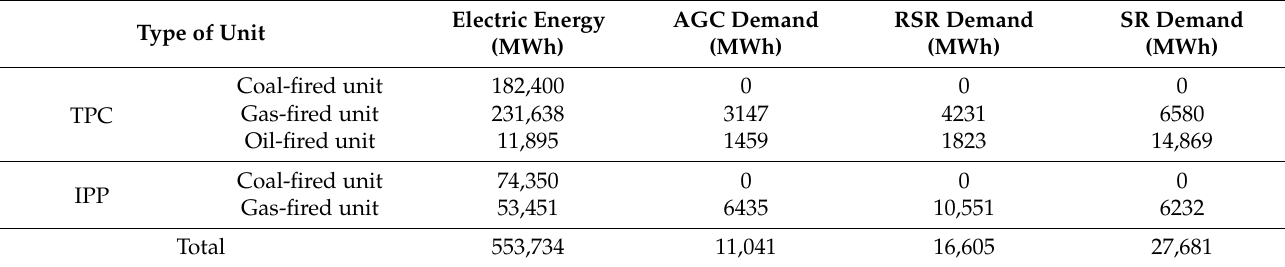
Figure 5. Unit commitment in summer. Table 3. Assigned quantities of various units on a typical summer day.